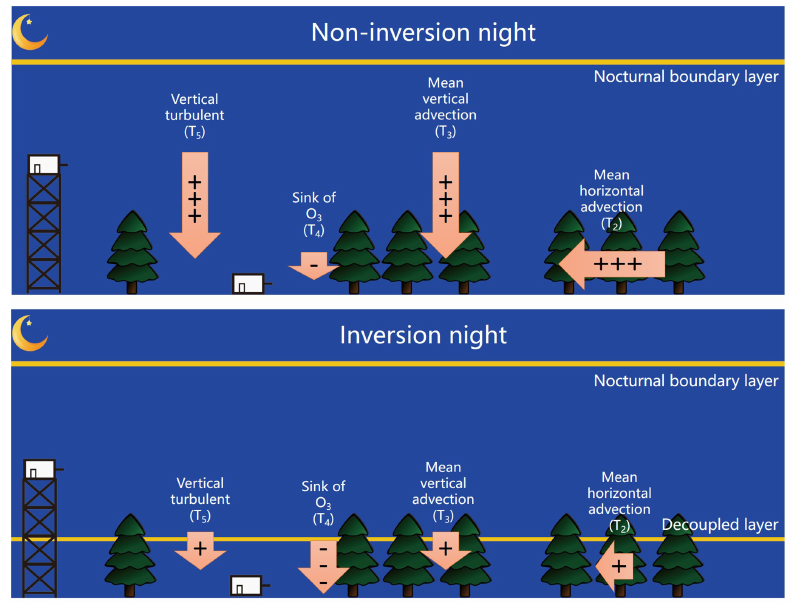
Figure 6. Schematic figure showing how vertical mixing, vertical advection, and horizontal advection influence ground-level O 3 concentra- tions differently on non-inversion nights and inversion nights at the SMEAR II